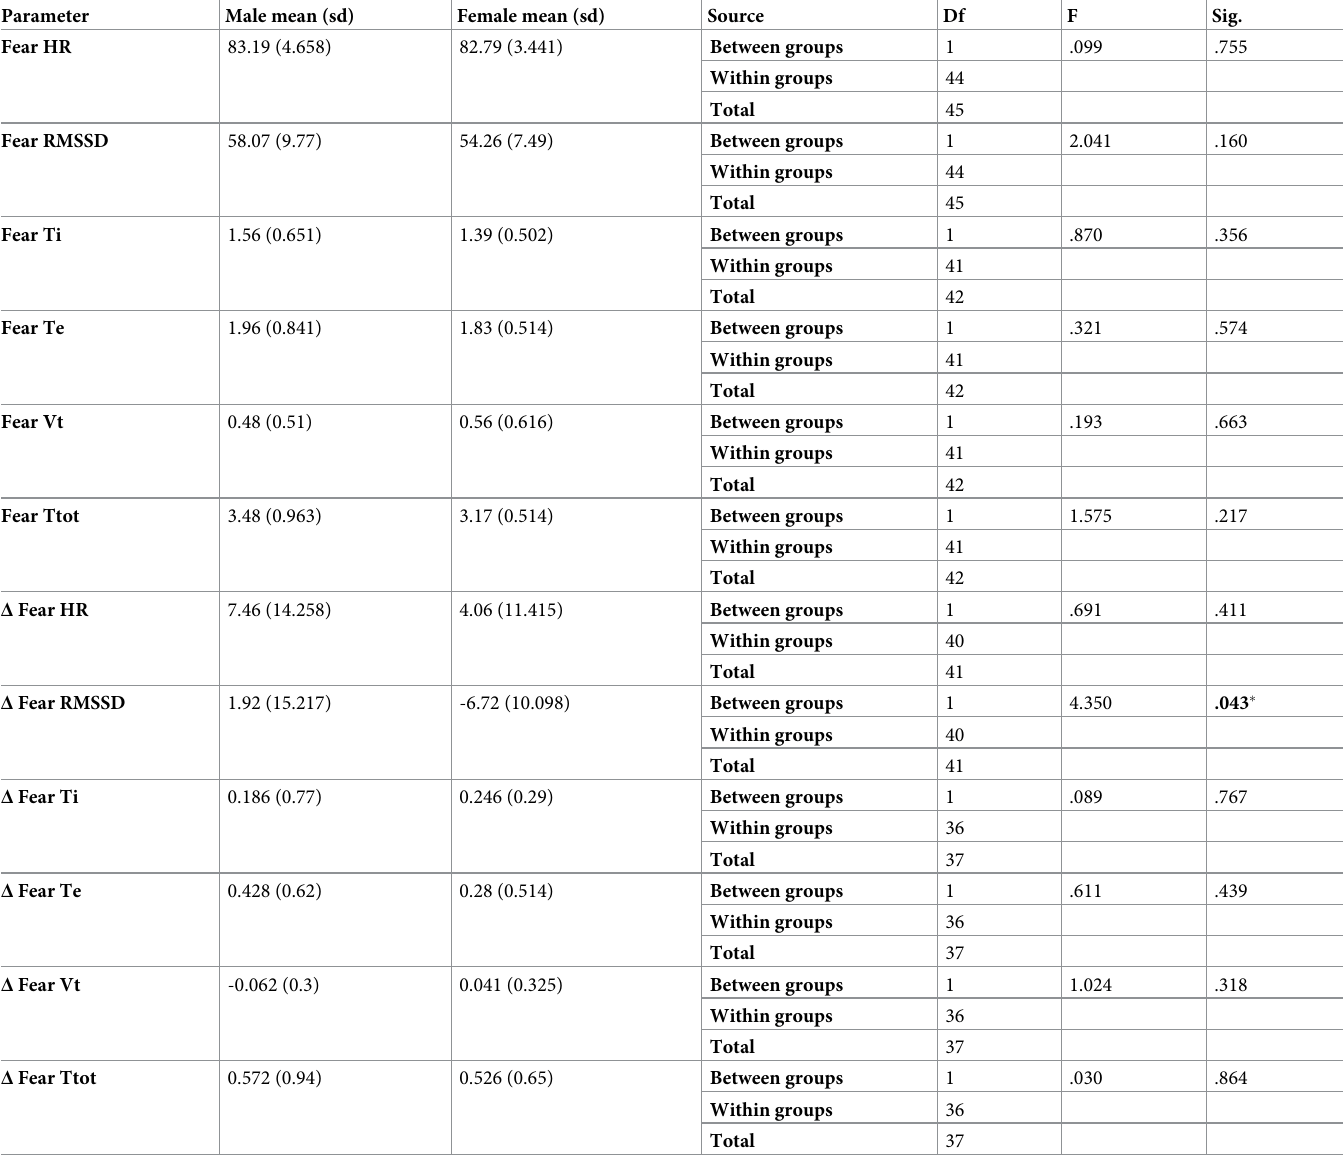
Table 8. ANOVA for autonomic (cardiac and respiratory) response and reactivity during fear of males and females. Parameter Male mean